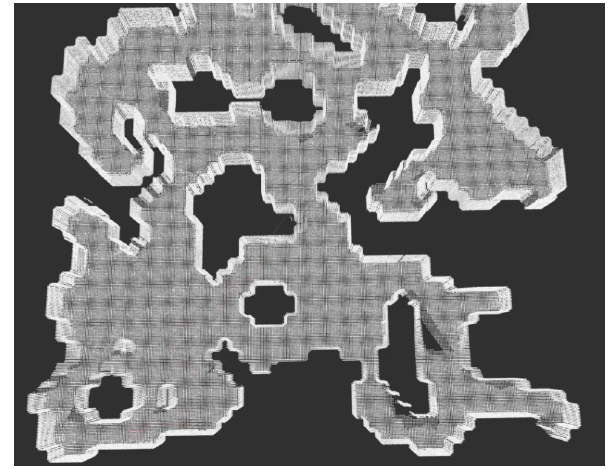
Figure 3. NanoMap mapping simulation